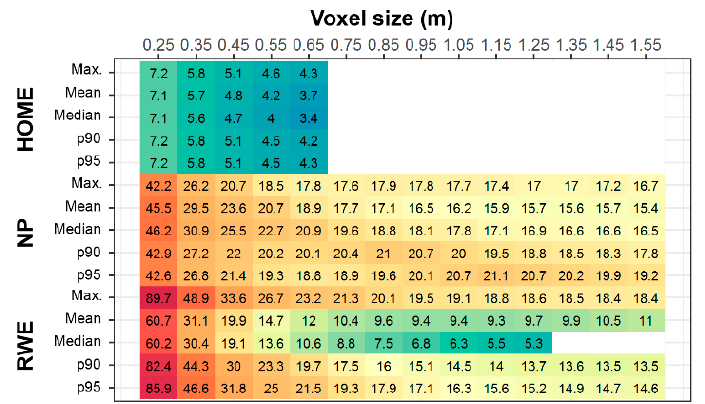
Figure 1. Average pulse density at which the corresponding ALS FW metric (HOME: height of median energy; NP: number of peaks; and RWE: return waveform energy) becomes stable for the different voxel sizes and assignation values. Smallest and largest values are represented by blue and red colors, respectively.